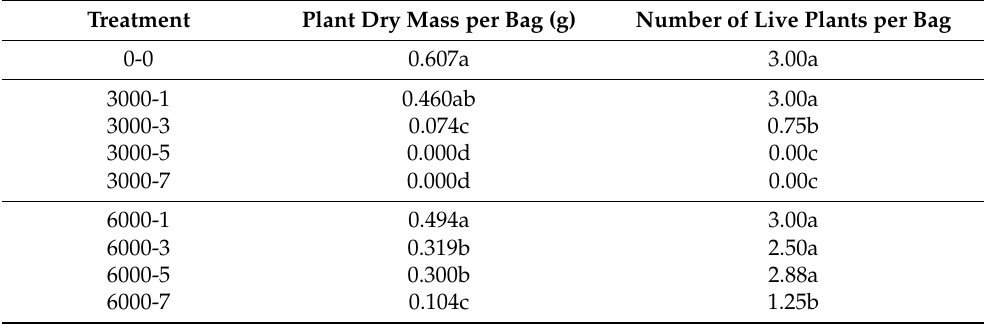
Table 5. Summary of treatments by applied voltage and energy on plant dry mass and number of live plants 15 DAT. Groups with the same letter in a column are homogenous subsets at p = 0.05 according to Kruskal–Wallis post hoc tests of pairwise comparisons.